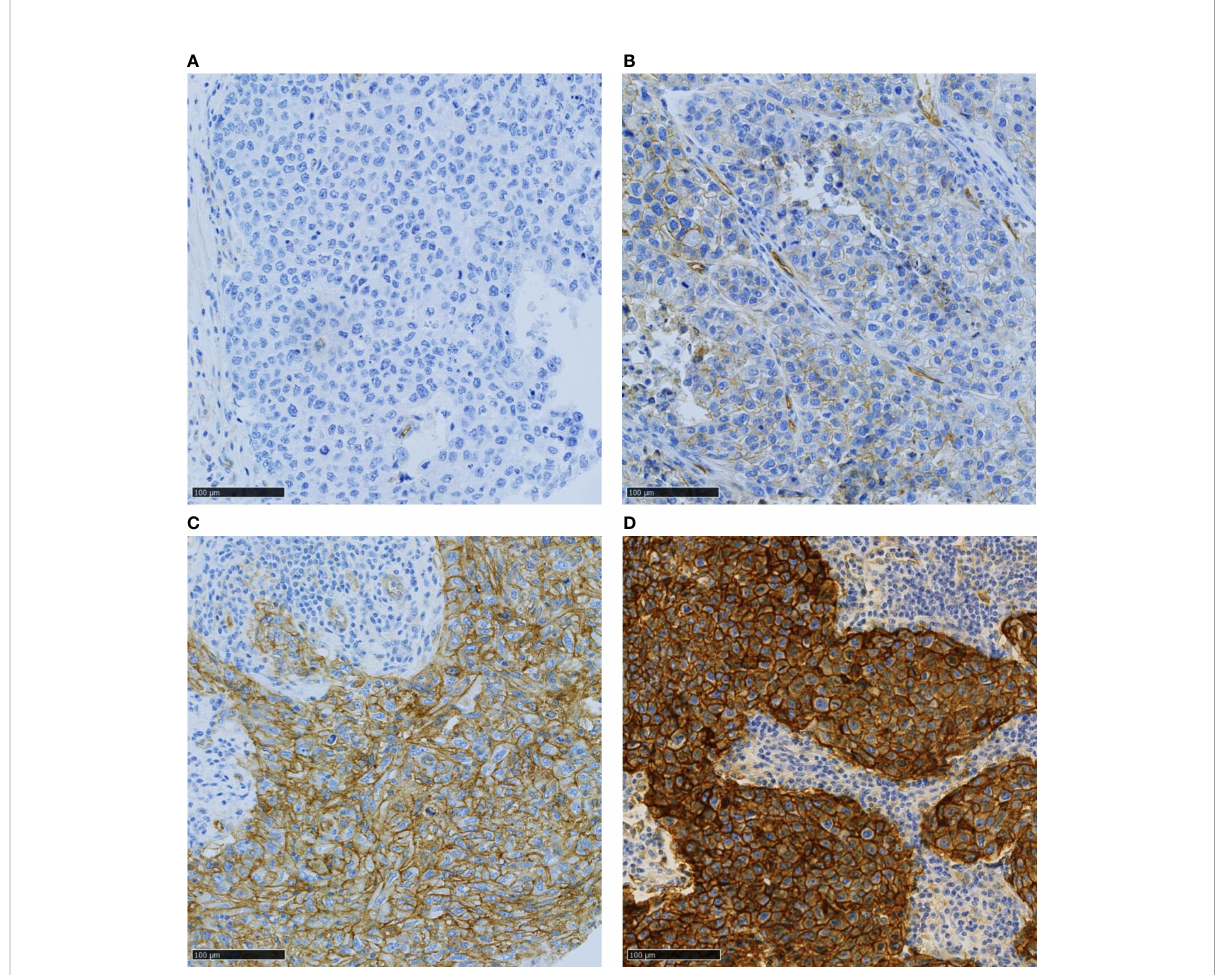
FIGURE 2 Representative images of TNBC samples with various PVR expression levels: (A) no, (B) weak, (C) moderate, and (D) strong signal intensity. Scale bar